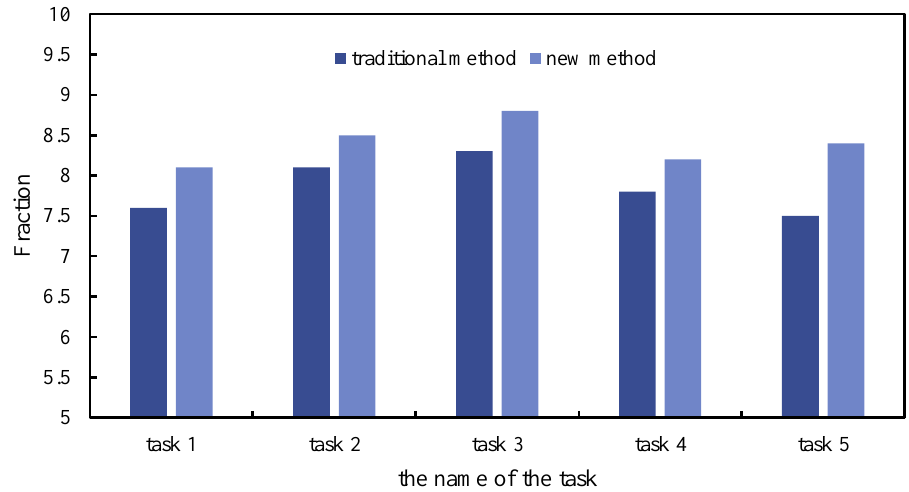
Figure 6. The scores of the UAV operators on the trajectory planning under the two methods.